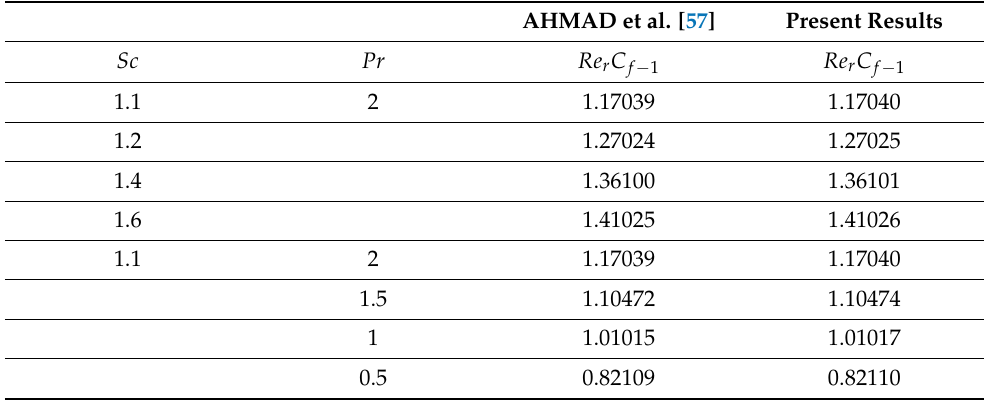
Table 7. Comparison results in the skin friction coefficient at the lower plate for Re = 0, γ = 0, σ = 0, λ = 0, M = 0,E = 0, n =